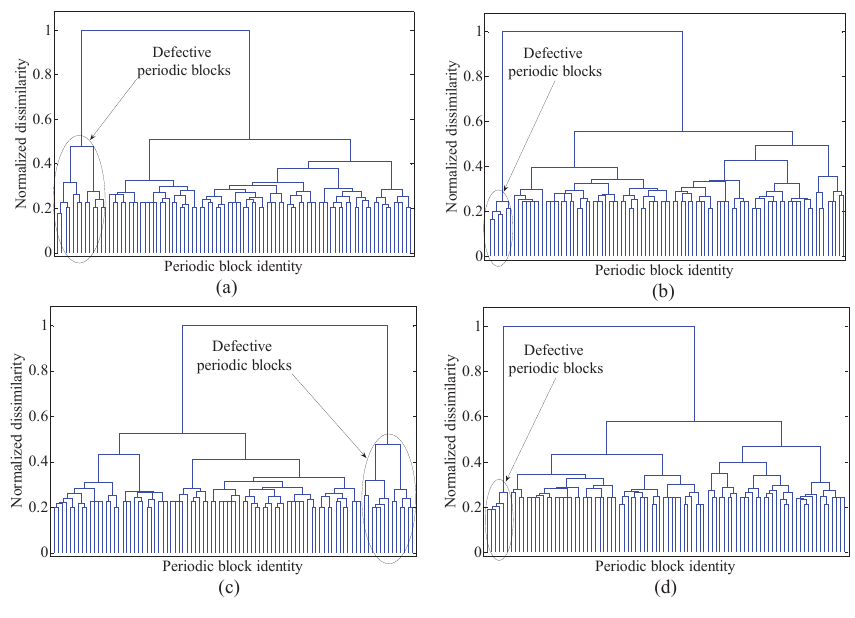
Figure 6. Dendrograms resulting from cluster analysis of chi-square dissimilarity matrix obtained from the test image by cropping from (a) top-left (b) bottom-left (c) top-right and (d) bottom-right corners. Defective blocks identified from these cropped images are (44, 64, 54, 34, 24, 74, 14, 23, 73, 33, 63, 43, and 53), (43, 63, 33, 53, 23, and 73), (44, 54, 24, 34, 64, 4, 14, 13, 63, 23, 53, 33, and 43) and (33, 53, 23, 43, 63, and 13). It may be noted that since the cropped images have more number of periodic blocks, the identities of the periodic blocks in the abscissa are not shown in order to avoid crowd and to have better